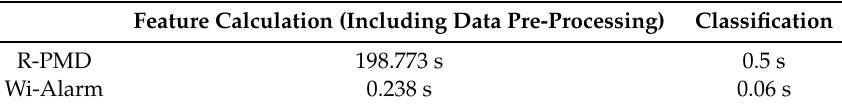
Figure 11. Receiver operating characteristic (ROC) curve of Wi-Alarm. Table 2. Runtimes of two